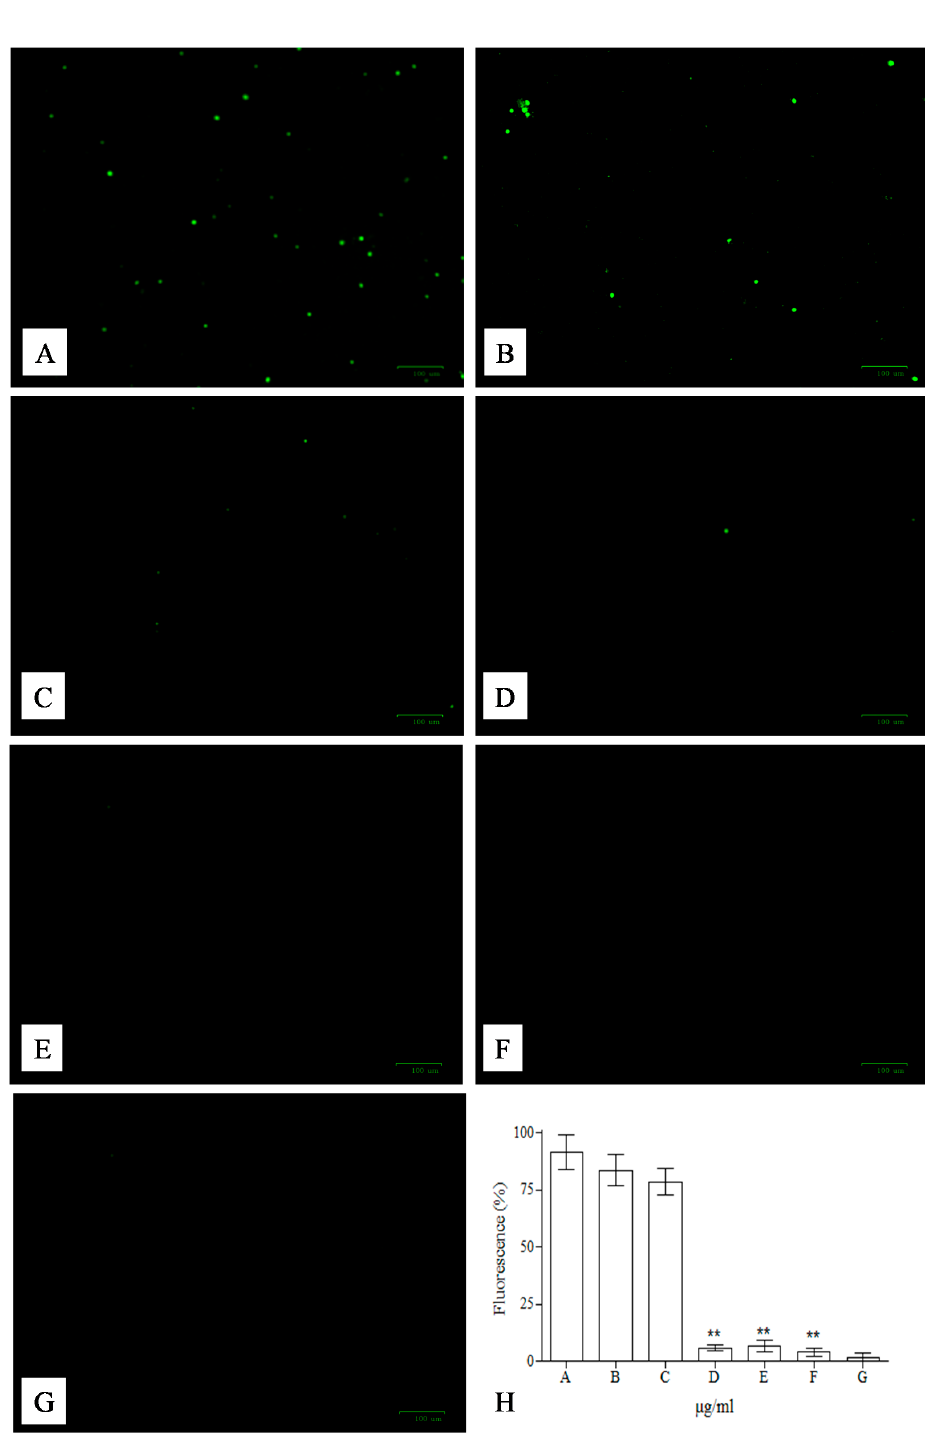
Figure 3. Intracellular reactive oxygen species (ROS) detection on human mononuclear cells t-BOOH treated with DCFH-DA. Mononuclear cells were treated with 50 µM t-BOOH ( A ) in the absence or in the presence of 2.5 ( B ), 5 ( C ), 10 ( D ), 25 ( E ), and 50 ( F ) µg/mL of EAC. Cells incubated in the same condition, but without t-BOOH and extract ( G ), were used as positive control. The green fluorescence, characteristic of DCF, was measured using ZOE Fluorescent Cell Imager. The elaboration of the fluorescence of the image has been performed with Image J software and the obtained arbitrary unit of fluorescence expressed in percentage ( H ). Data shown are representative of three independent experiments. Asterisks (**) indicate a significant difference with respect to control ( P < 0.05).